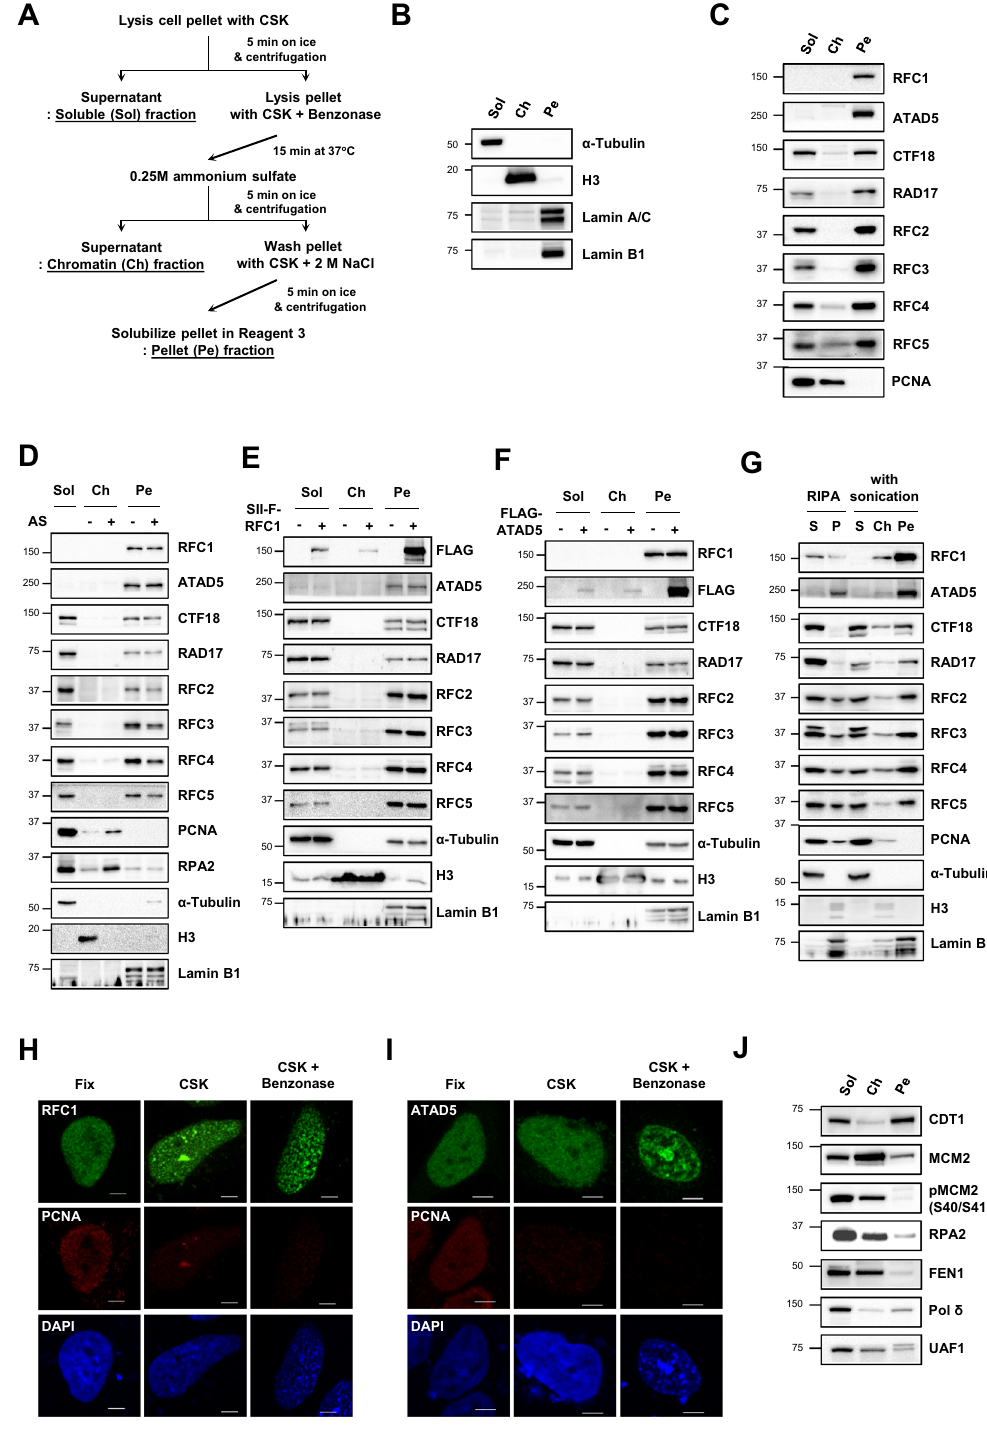
Figure 1. RFC/RLC proteins are present in nuclease- and high salt-resistant protein fraction. ( A ) The scheme for protein fractionation method. Detailed procedure was described in the method section. ( B – F , J ) HeLa cells were fractionated as the scheme in ( A ). Soluble (Sol), chromatin (Ch) and pellet (Pe) fractions were subjected to immunoblotting as indicated. ( D ) Chromatin and pellet fractions were prepared with or without ammonium sulfate (AS) step (−). ( E , F ) HeLa cells were transfected with Strep-tag II-FLAG-tagged RFC1 (SII-F-RFC1) (E) or 3xFLAG-tagged ATAD5 (FLAG-ATAD5) cDNA 48 h before protein fractionation. ( G ) ( left two lanes ) HeLa cells were lysed with RIPA buffer without Benzonase nuclease treatment, and soluble (S) and pellet (P) proteins were subjected to immunoblotting. ( right three lanes ) HeLa cells were fractionated as the scheme in ( A ) but sonication step was added after Benzonase nuclease treatment. ( H , I ) HeLa cells were transfected with mNeonGreen-tagged RFC1 ( H ) or mNeonGreen-tagged ATAD5 ( I ) cDNA. Forty-eight hours after transfection, cells were fixed or pre-treated with CSK alone or CSK plus Benzonase with the same condition as in ( A ) and then fixed for immunostaining. Scale bar = 5 μm. ( B – G , J ) Uncropped blot images are presented in Supplementary Fig.